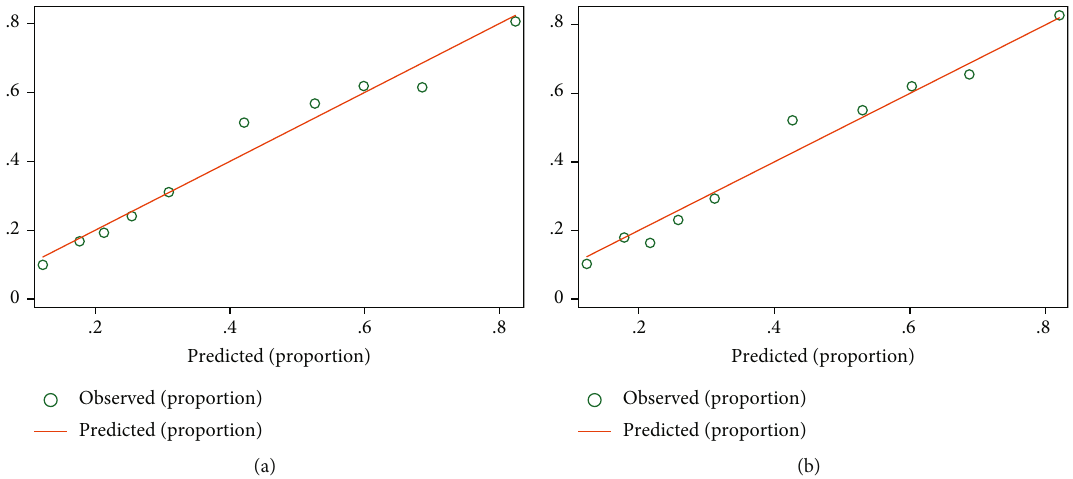
Figure 3: The calibration curve of nomogram for predicting developing pulmonary infection in the training ((a) P = 0 : 26 ) and testing ((b) P = 0 : 59 ) dataset. The calibration focused on the accuracy of the absolute risk prediction of the model (i.e., the consistency between the probability of serious postoperative severity predicted by the model and that actually observed). The y -axis represents the actual rate of developing pulmonary infection. The x -axis represents the predicted probability of developing pulmonary infection. For a nomogram with better calibration, the scatter points should be arranged along a 45 ° diagonal line. The Hosmer-Lemeshow goodness-of- fi t test is often used to compare whether signi fi cant di ff erences exist between the prediction probability and the actual occurrence, with P > 0 : 05 indicating no statistically signi fi cant di ff erence, and the calibration of the model was